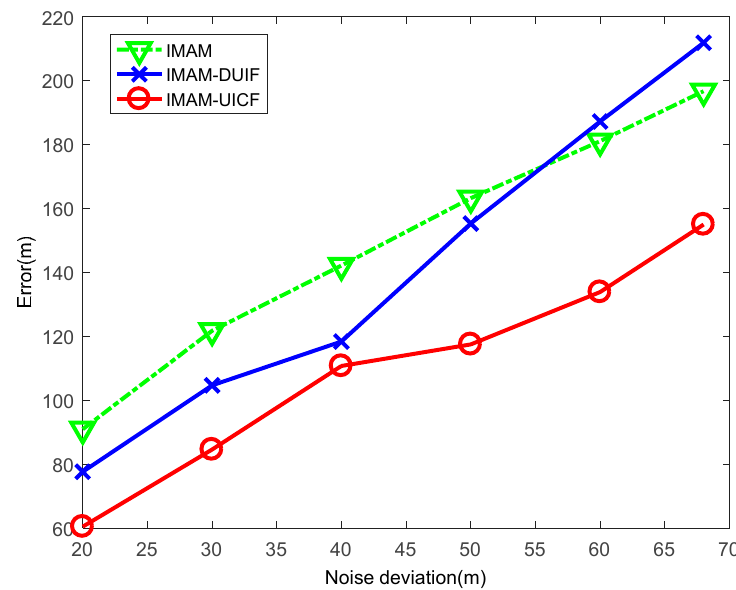
Figure 13. The position ARMSE of the three algorithms with varying measurement noise.